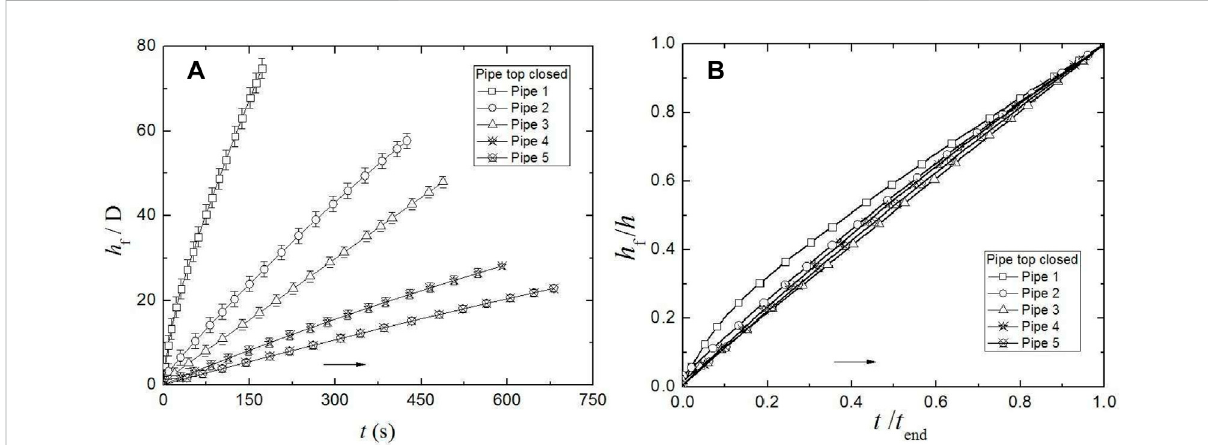
FIGURE 5 (A) Measuredheightofthefoamfrontnormalizedtothepipediameter, h f / D ,asafunctionoftimefordifferentpipediametersaslistedinTable1 forthecaseofclosed-toppipes.Theerrorbarsdepictedoneachmeasurementcorrespondtostandarderrors.Thestandarderrorsare:4.8%forPipe 1,4.0% forPipe2,3.5%for Pipe3, 3.0%for Pipe4,and2.5%for Pipe5with con fi denceintervalsaround96%. (B) Same dataas in (A) butnormalized to the height of the vertical pipe, h f / h , as a function of time normalized to the foam generation time, t / t end . The arrows in (A) and (B) indicate the direction in which the pipe diameter increases.